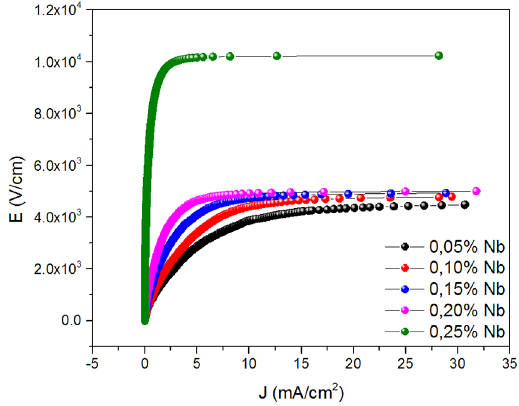
Figure 4. DC measurements for all compositions showing that both the breakdown electric field and the nonlinear coefficient increases with the amount of niobium.